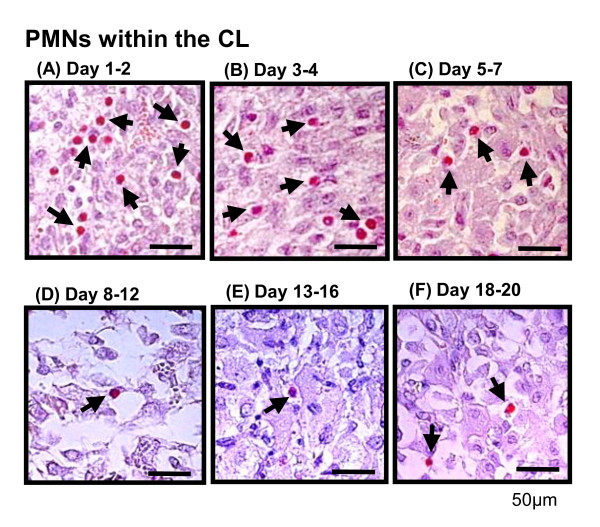
Distribution of PMNs in the bovine CL throughout the luteal phase. Figure 2A-F indicate typical images of PMNs by PAS staining in the CL during the estrous cycle. Black arrows indicate PMNs. PMNs were clear granule and segmented nuclear. As Figure 1A, on day 1-2 and 3-4 of the estrous cycle, high numbers of PMNs were detected within the luteal tissue (Figure 2A and B). Scale bars indicate 50 μm.